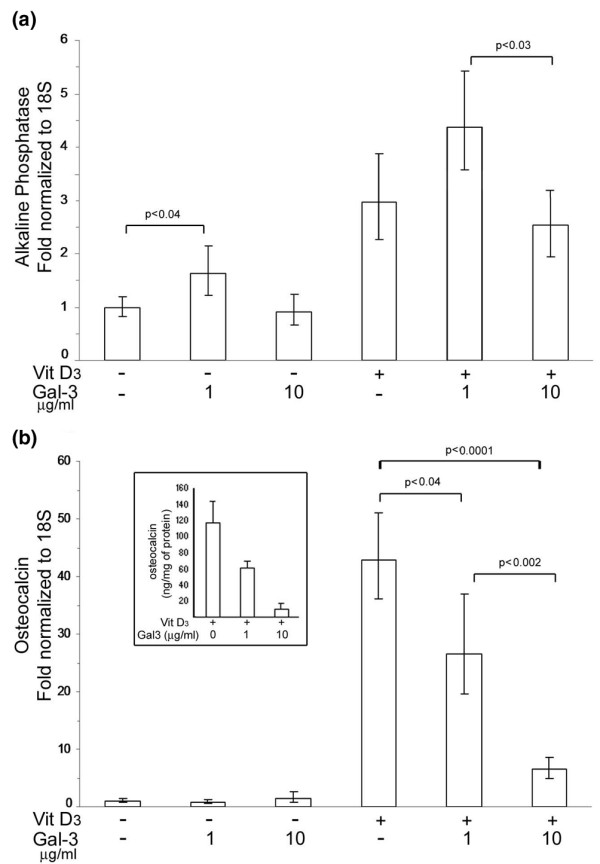
Effects of exogenous galectin-3 (gal-3) on markers of subchondral bone osteoblasts. Osteoblasts were treated with 1 or 10 μg/ml of recombinant human gal-3 in the presence or absence of vitamin D3. Both (a) alkaline phosphatase and (b) osteocalcin expression were analyzed by real time RT-PCR. Insert illustrates the protein level of osteocalcin. N = 4.